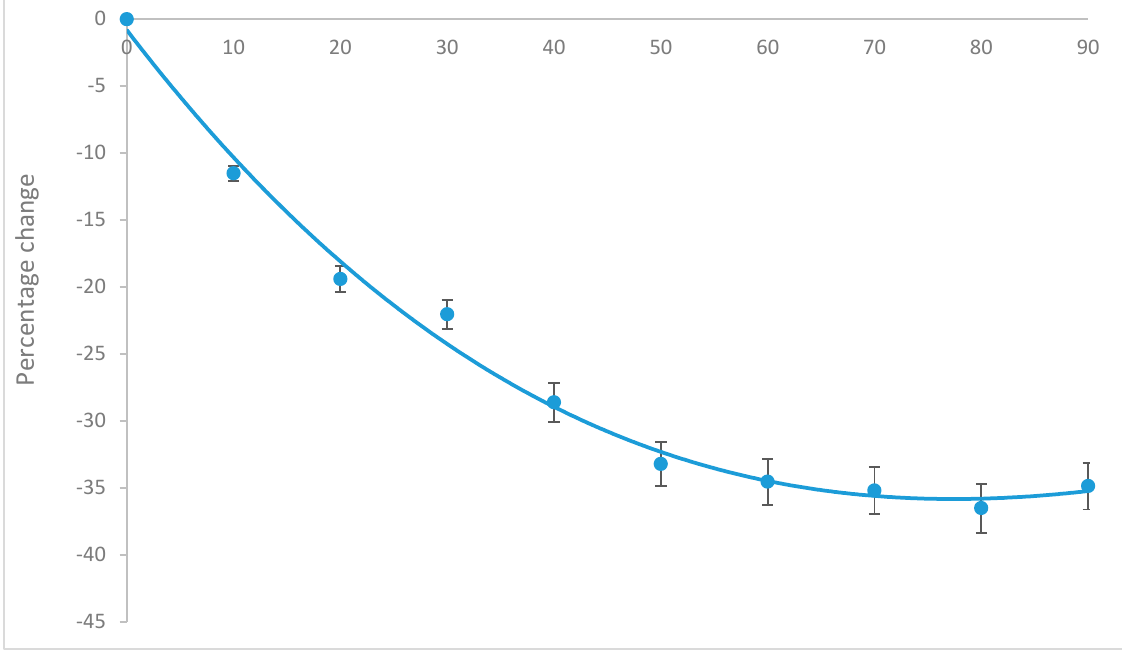
Figure 6. Time-dependent change of the degradation of reduced glutathione (GSH) from extracted cardiac tissue over time at 4 °C. Data are presented as mean ± SEM ( n = 3).